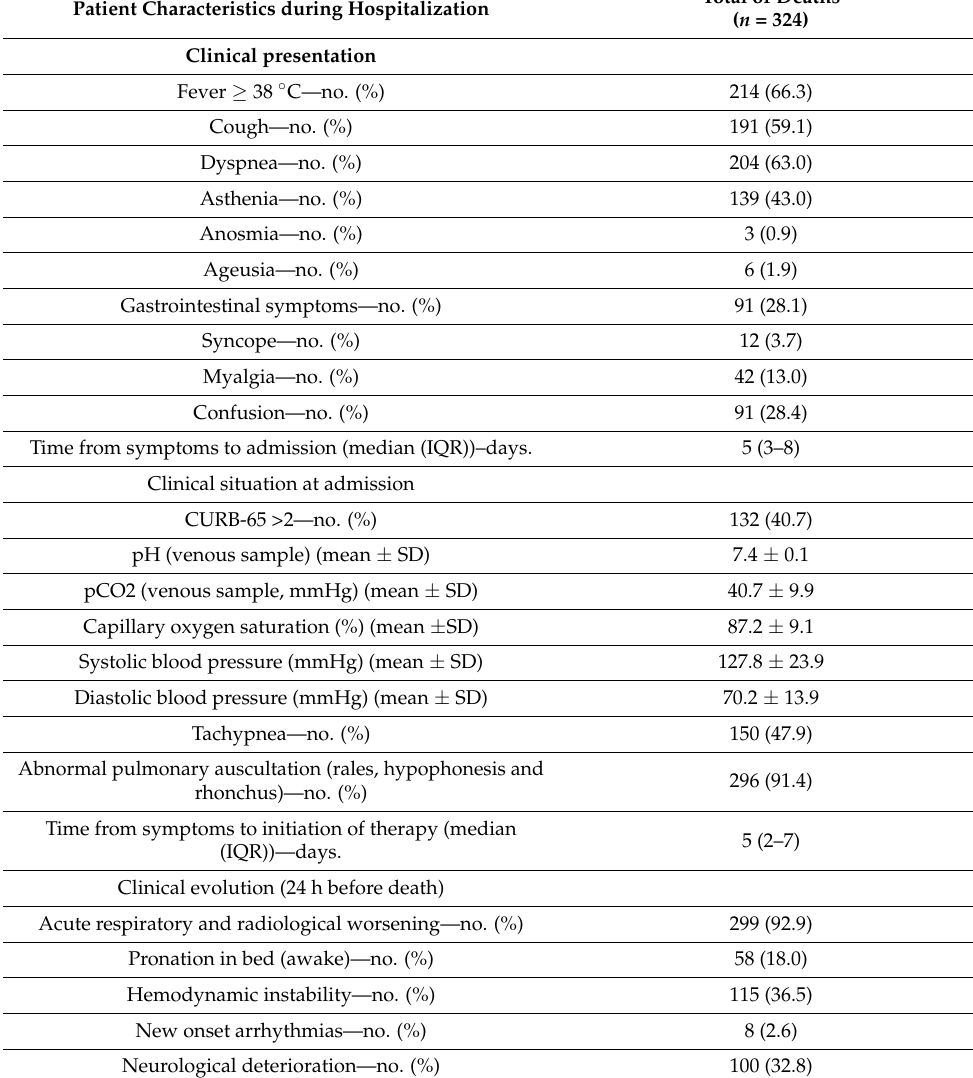
Table 2. Patient characteristics during